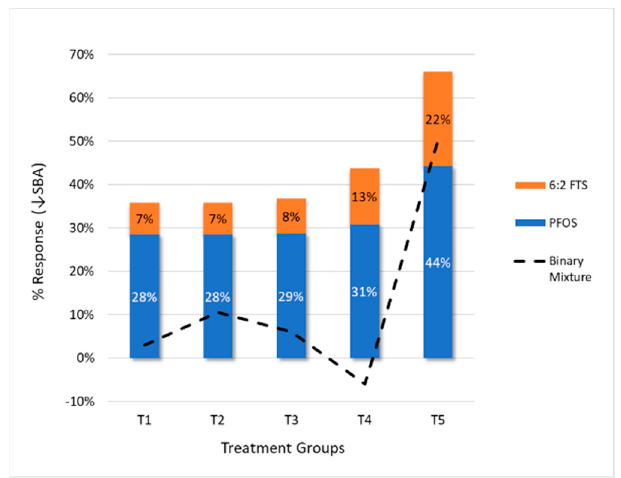
Figure 9. Evaluation of the assumption of response additivity for the binary mixtures study, using the linear D–R models developed from the individual experiments. The columns represent the predicted responses of both chemicals given their measured concentrations in the binary mixtures study, applied to the D–R models developed from the individual experiments. The dotted line is the actual observed response for the binary mixtures study.